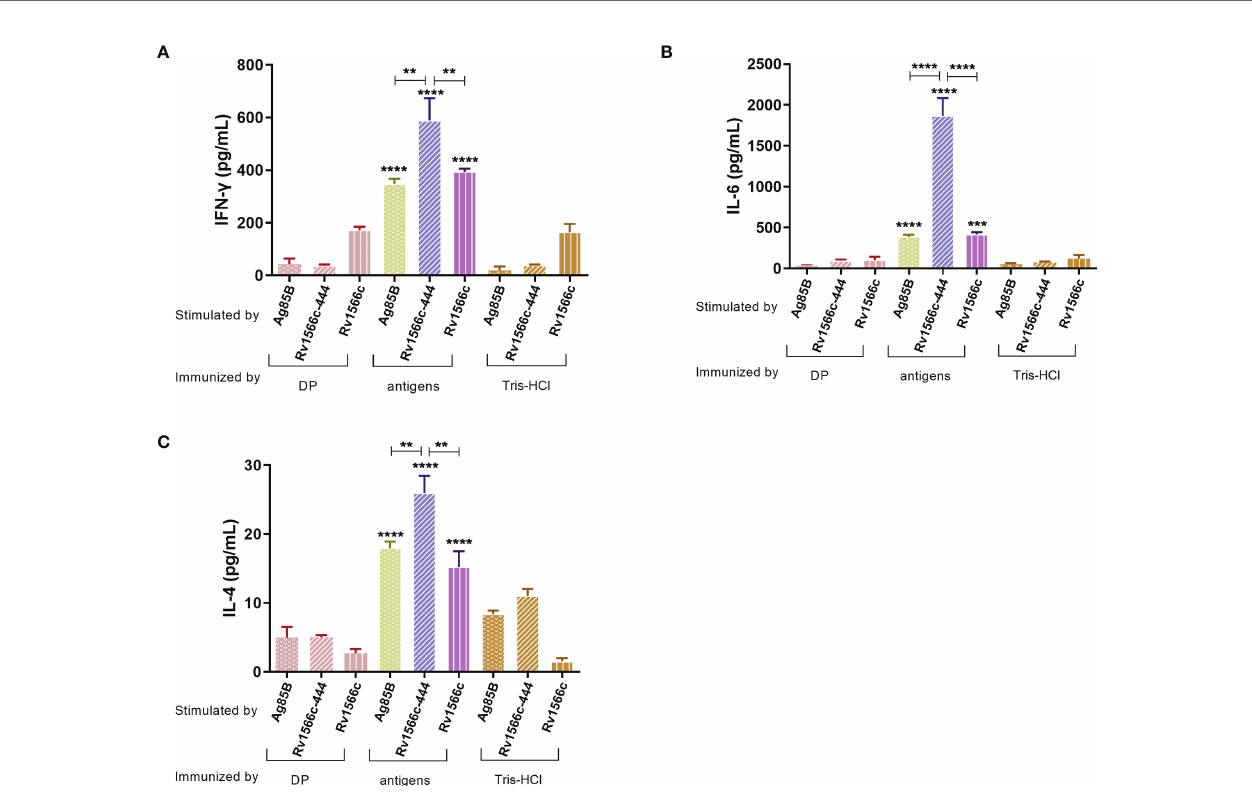
FIGURE 5 | Antigen-speci fi c cytokine levels were released from the splenocytes of the immunized mice. After lymphocytes were isolated from BALB/c mice immunized with the constructed vaccines, they were stimulated with antigens used in the vaccines respectively. BALB/c mice immunized with DP mixture or Tris-HCl were also stimulated with three antigens respectively. The concentration of three different cytokines (A) IFN- g , (B) IL-6, and (C) IL-4 were measured by ELISA assays. The signi fi cant differences between antigen and negative controls (DP and Tris-HCl groups) both stimulated with the same antigen are represented by asterisks above the bar; signi fi cant differences among three antigens groups (Rv1566c-444, Ag85B, and Rv1566c) are presented by capped lines with asterisks. The statistical signi fi cance was determined using one-way ANOVA with Turkey ’ s multiple comparison tests (**P < 0.01, ***P < 0.001, ****P <